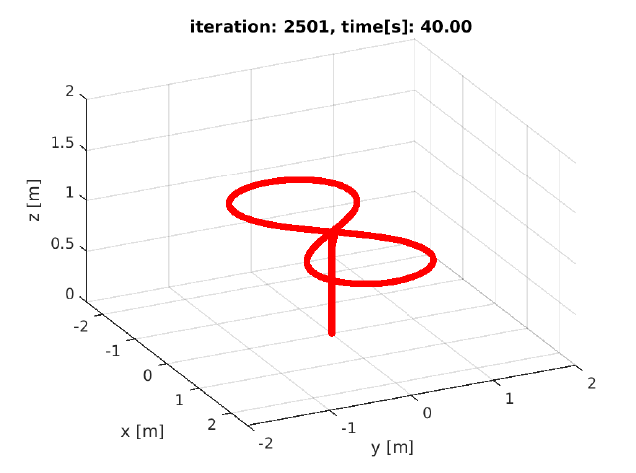
Figure 29. 3dPlot of IOSMC with gains adjusted.